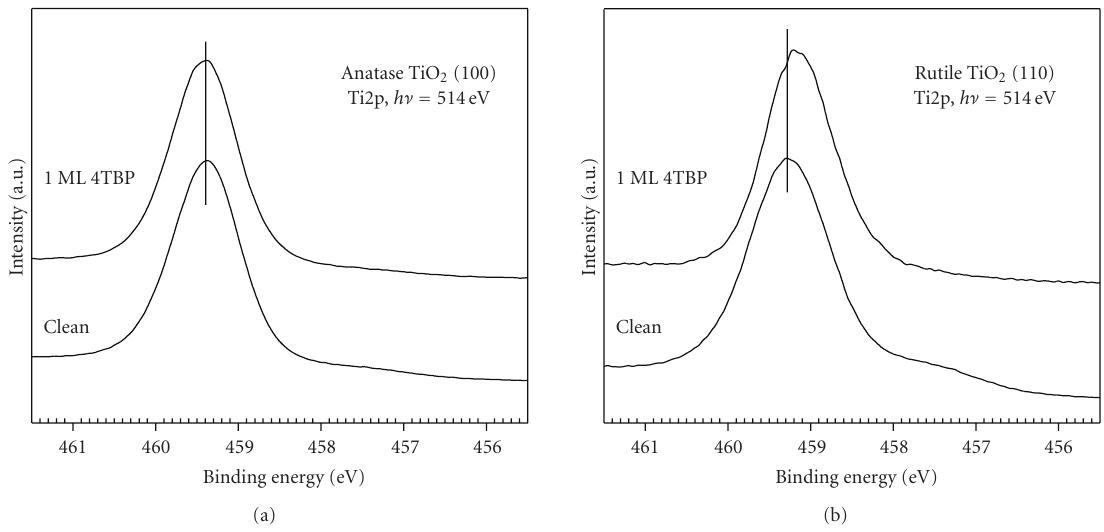
Figure 1: Ti2p spectra from clean and 4TP-covered TiO 2 (100) and TiO 2 (110) surfaces. The photon energy was 514